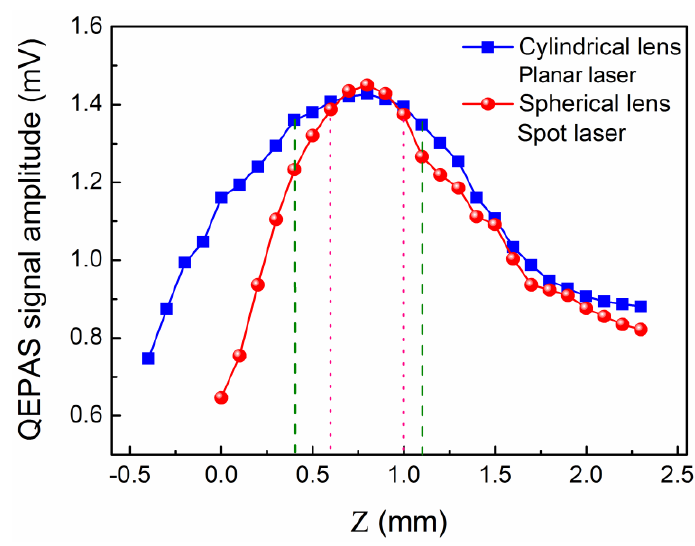
Figure 4. Measured QEPAS signal amplitude as a function of Z (see Figure 1) at a modulation depth of 0.44 cm −1 for two different focusing lenses.